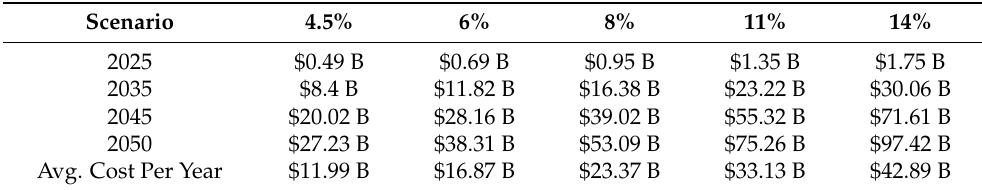
Table 6. CO 2 -eq avoided per year based on EU ETS price forecast and quantity expected to be avoided according to each scenario for 2025, 2035, 2045, and 2050.